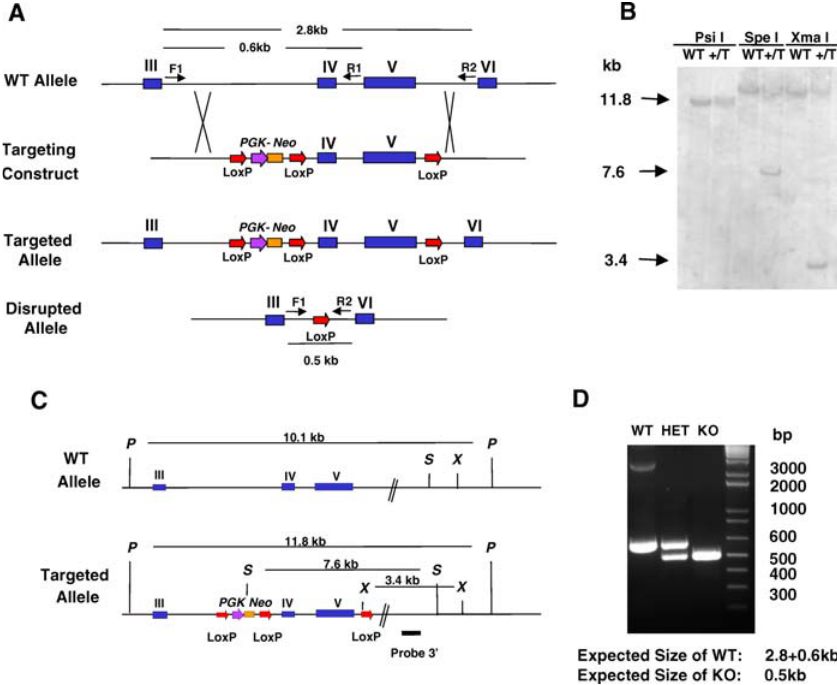
Figure 1. Generation of the PGC1 b KO Mouse (A) Design of the targeting construct for the generation of the PGC1 b KO mouse using a phosphoglycerate kinase-neomycin phosphotransferase (PGK- Neo)–based LoxP cassette inserted between exons III and IV and a third LoxP site between exons V and VI. Total collapse of the LoxP sites deletes exons 4 and 5 of the PGC-1 b gene. (B) A Southern blot confirming the generation of the targeted allele in ES cells. WT, wild type ES cells; þ /T, ES cells heterozygous for the targeted allele, T. (C) Schematic showing the restriction digest strategy for the southern blot confirming the generation of the targeted allele in ES cells. P, PsiI; X, XmaI; S, SpeI. (D) Confirmation of the total LoxP collapse and generation of KO mice by PCR from genomic DNA using primers F1, R1, and R2 shown in (A). DOI: 10.1371/journal.pbio.0040369.g001